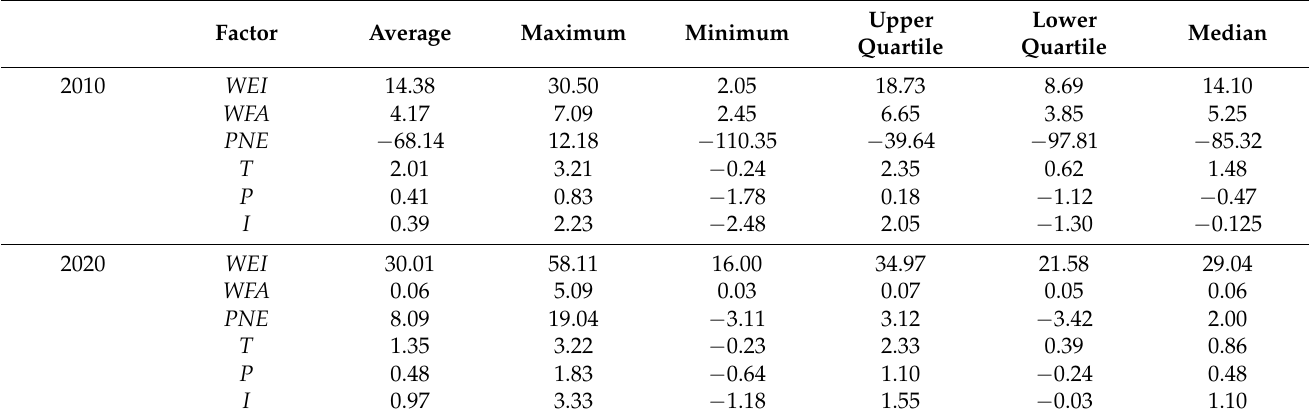
Table 3. SCA-GWR model regression coefficient descriptive